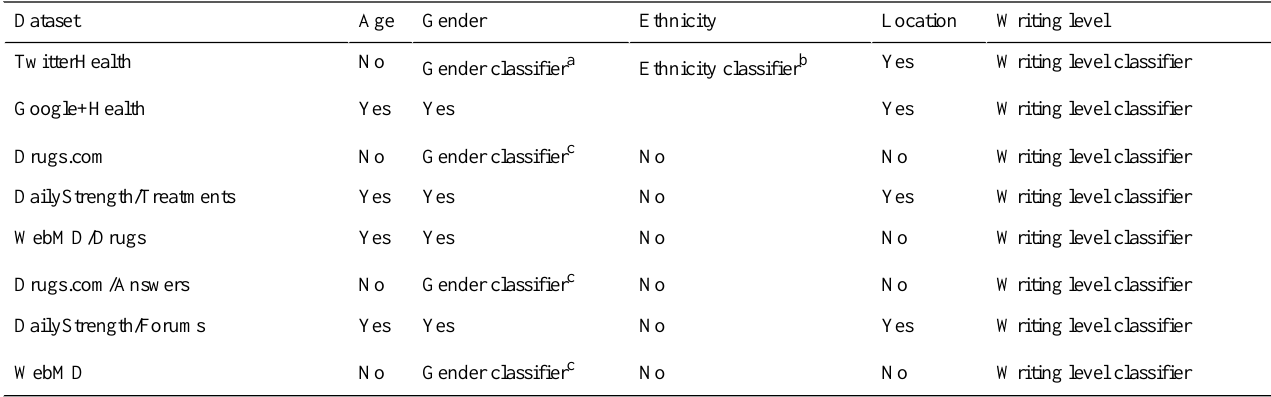
Table 2. List of all used sources with the available attributes.